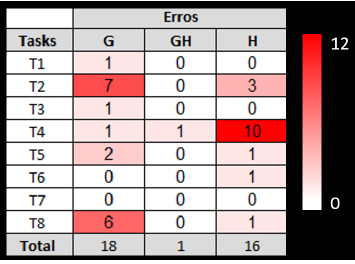
Figure 15. Total of errors in